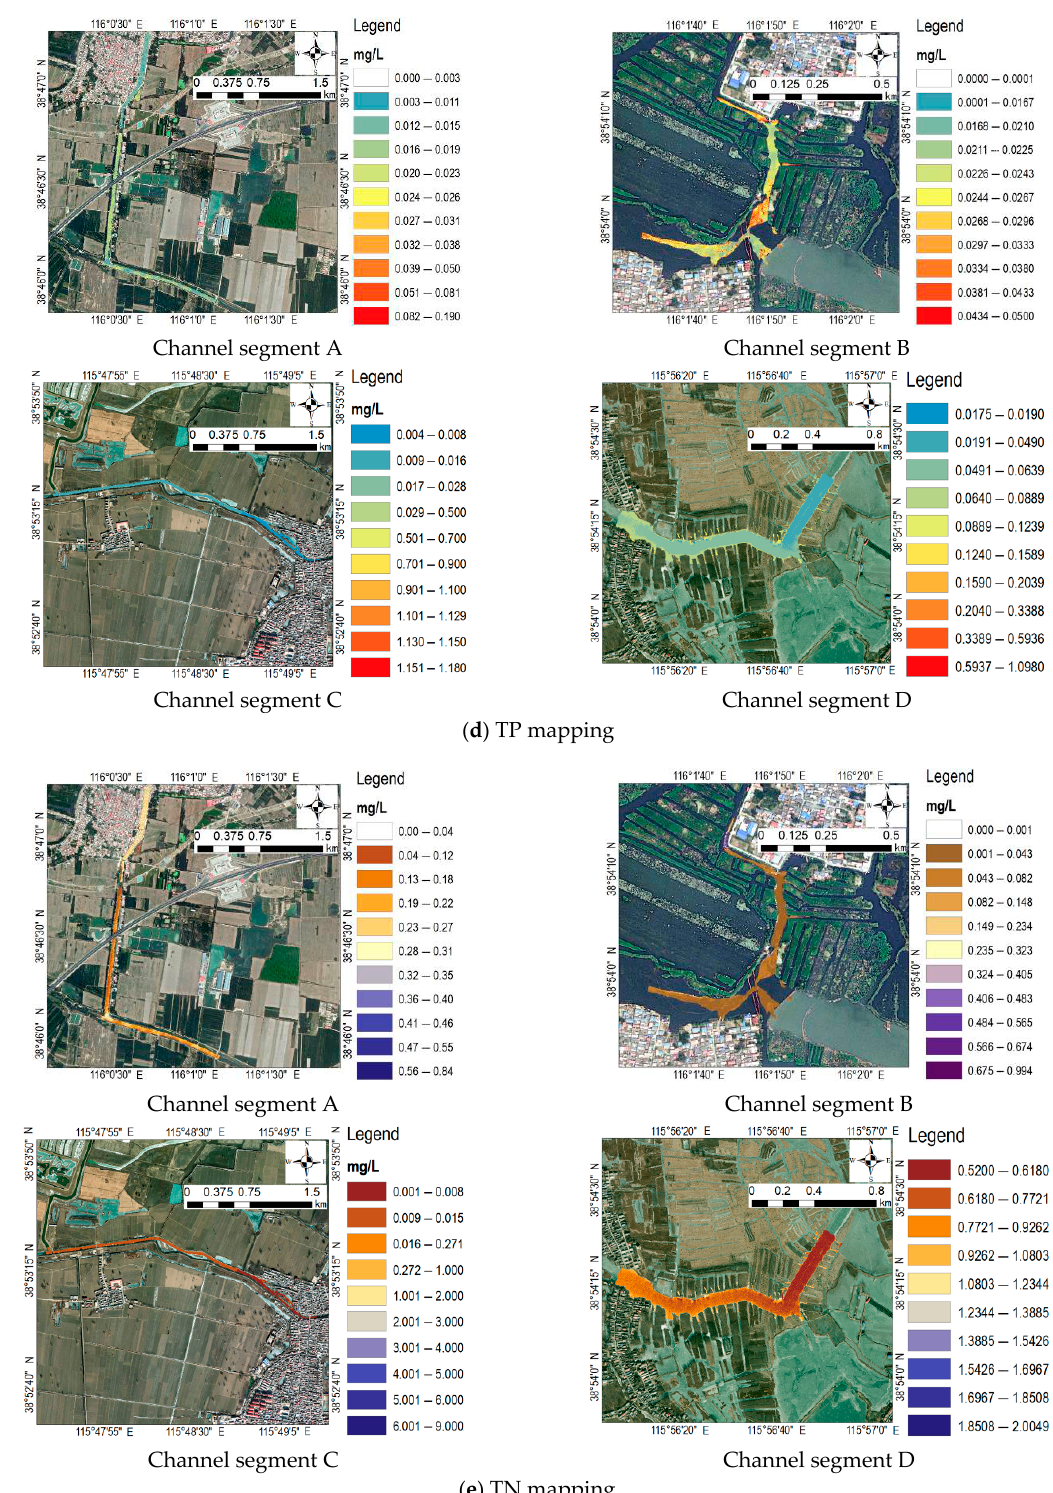
Figure 4. Mapping results of five water quality indicators in four river segments. ( a ) The content of COD indicates the rule of high value in the area where the river meets and is close to the residential area; ( b ) PI is uniformly distributed in the river; ( c ) The AN content near the bank and at the river bend is higher than that in other river sections; ( d ) The overall TP content of the river is low, and the high value occurs at the con fl uence of the river and near the bank; ( e ) The TN content of the whole river channel is low and evenly distributed.